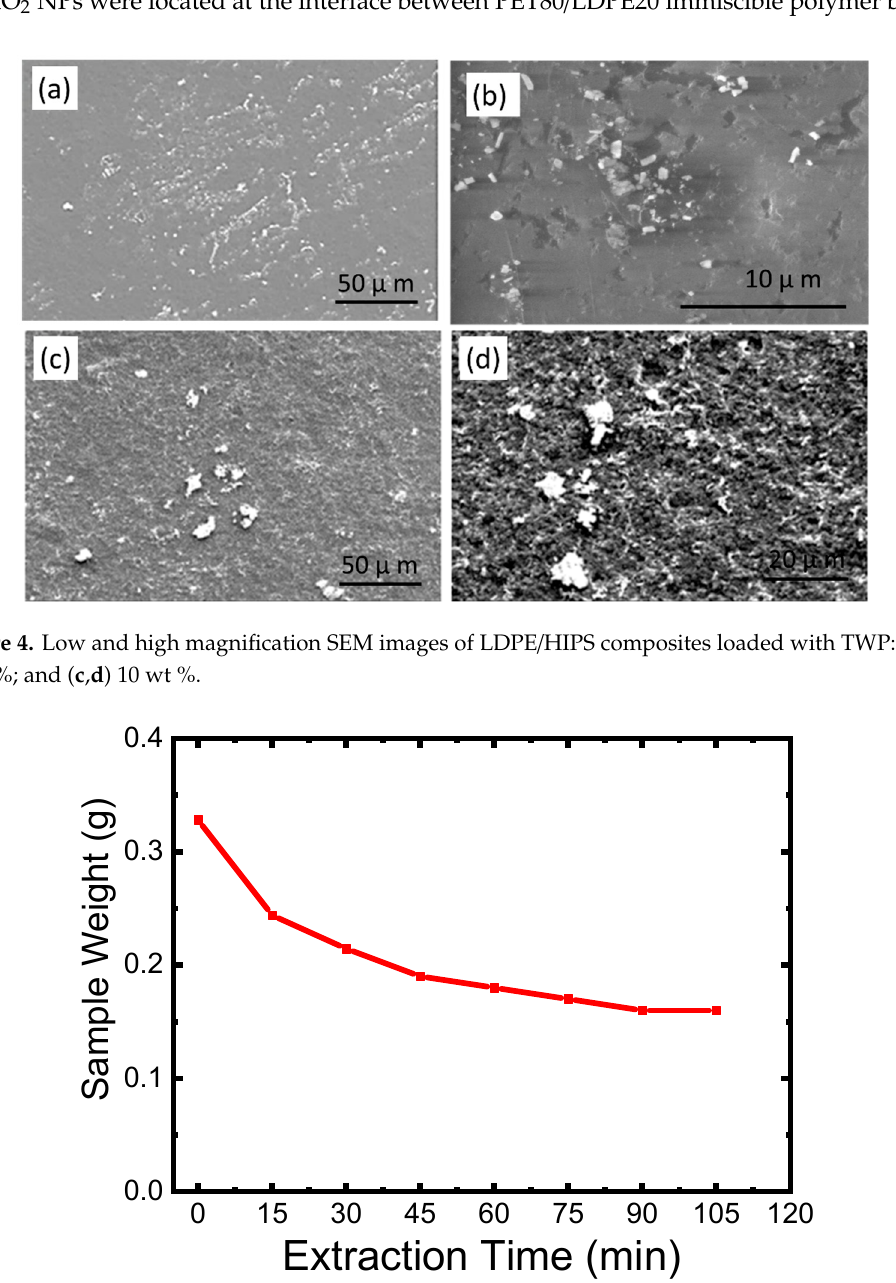
Figure 5. Variation of polymer composite sample weight as the function of time.